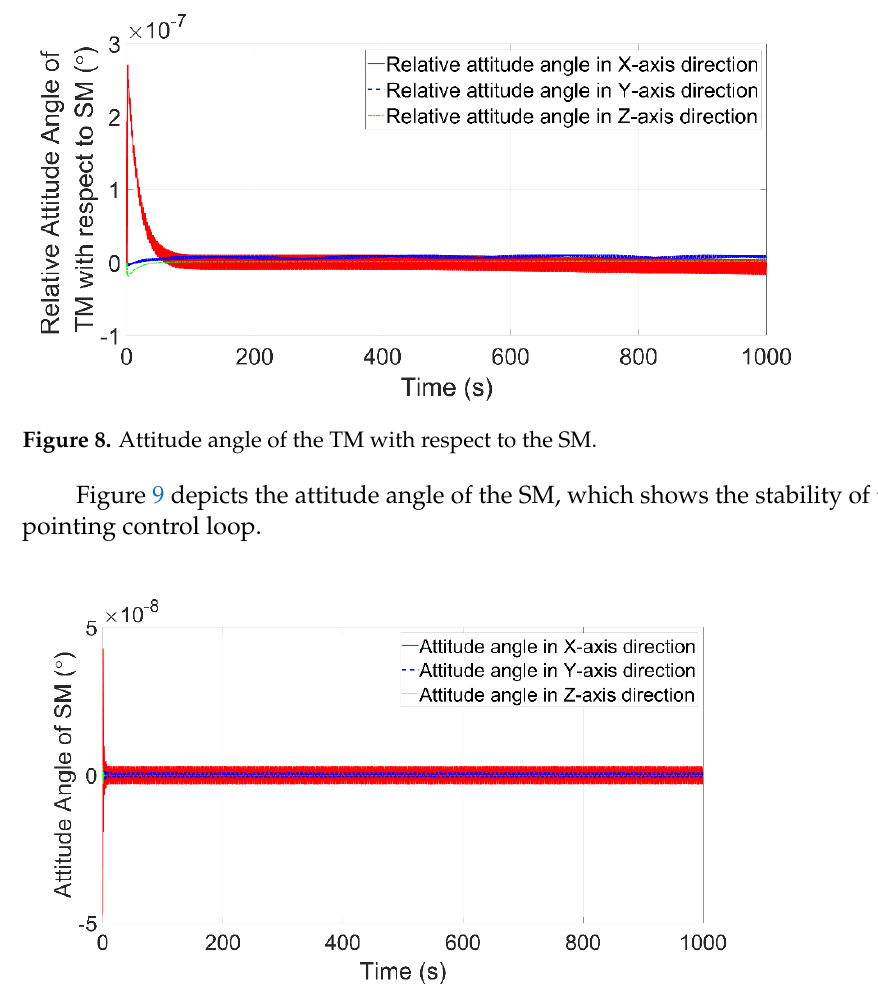
Figure 7. Centroid position of the TM with respect to the SM. TM, test mass.